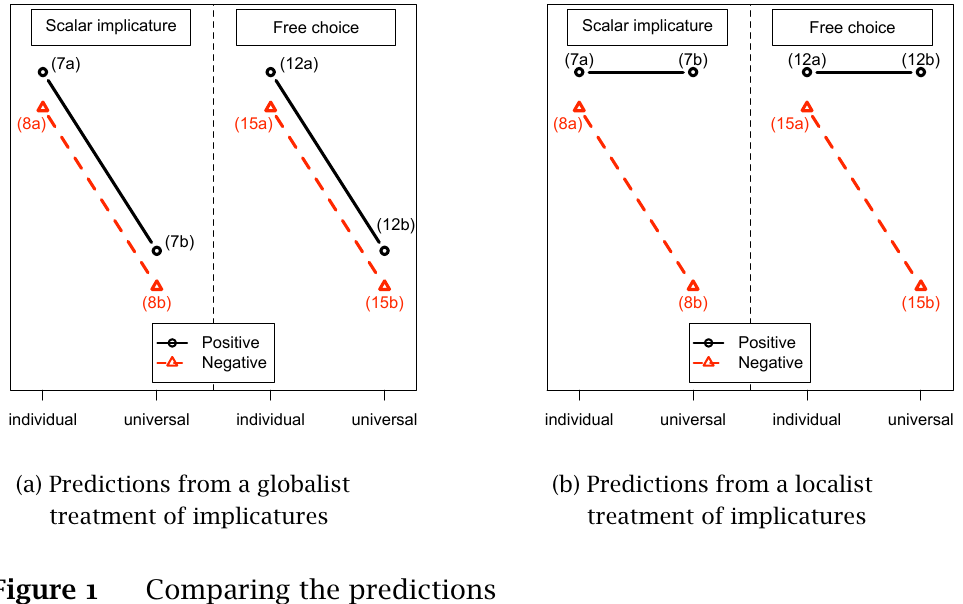
Figure 1 Comparing the